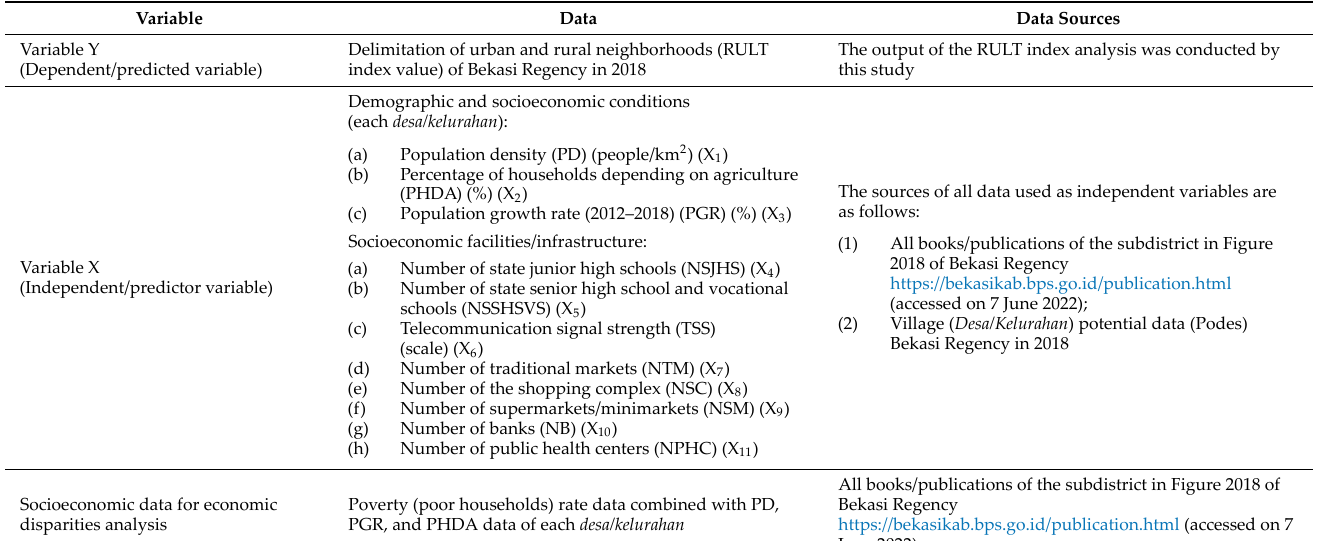
Table 1. A list of data used in this